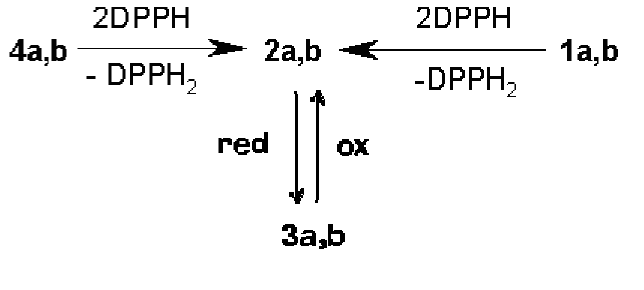
Fig. 2 Formation of betainic compounds 2a,b and the corresponding hydrazines